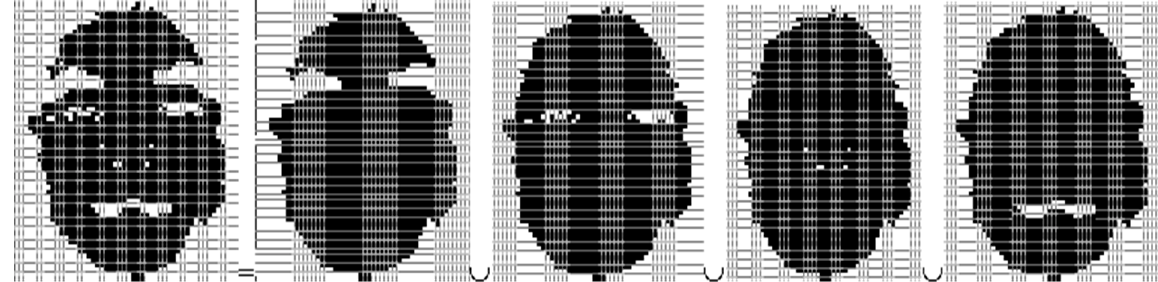
Figure 6. Qualitative transformation functor conversion from two dimension pattern “A” into Hil- bert space. ( a ) Envelopes E(A) of several handwritten A, the intersections of sampling points x = a k and x = a k+1 , y = b k and y = b k+1 and a certain A ξ k = a k + ib k ， ξ k+1 = a k+1 + ib k+1 , and the intersection of x = a k and y = b k with E(A) [ μ k , ν k ] and [ α k , β k ]; ( b ) A Qualitative Criterion [ α , β ] for Recognizing Pattern A in 2D, and the Neighborhood ( ξ k , ξ k+1 ) = (a k ,b k ,a k+1, b k+1 ) of Tensor {[ α k , β k ] × [ μ k , ν k ]} ⊗ {[ α k+1 , β k+1 ] ×